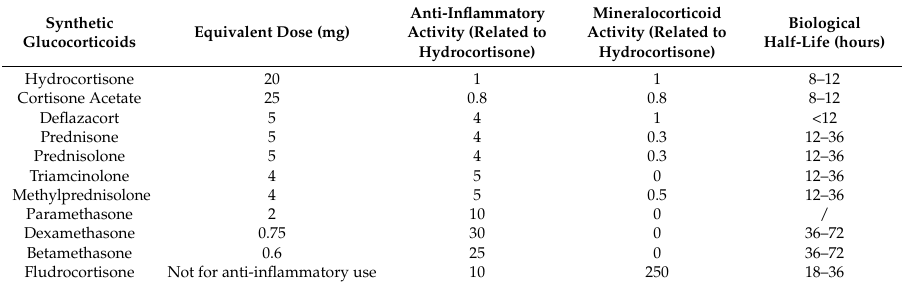
Table 1. Most used synthetic glucocorticoids and their characteristics [12]. Anti-inflammatory activity and mineralocorticoid activity of each compound are related to those of hydrocortisone, which is 1. The equivalent dose is expressed in